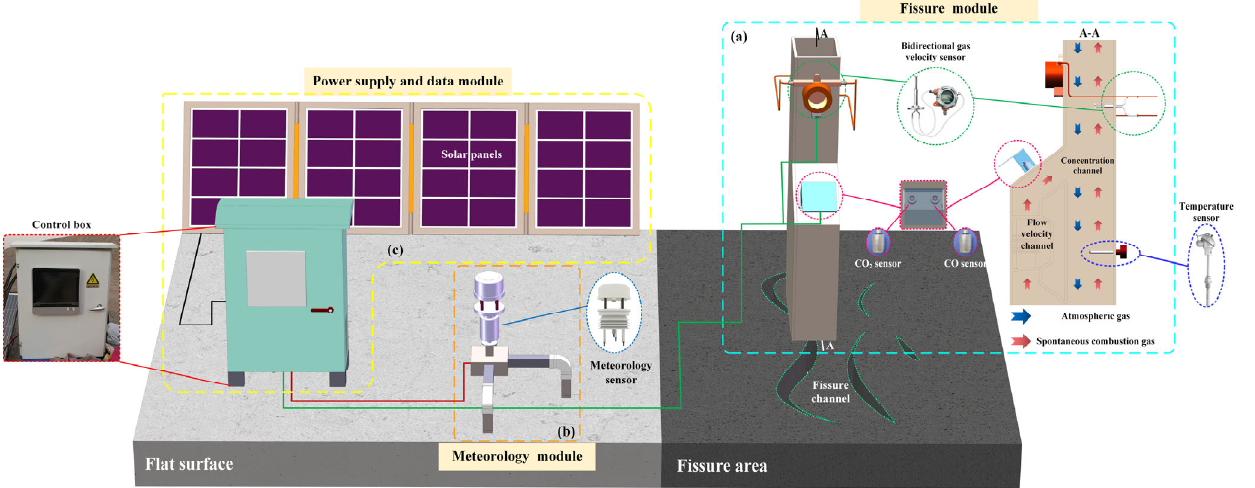
Figure 2. Schematic diagram of the in situ fissure channel monitoring system. ( a ) Fissure module; ( b ) Meteorological module; ( c ) Power supply and data module.